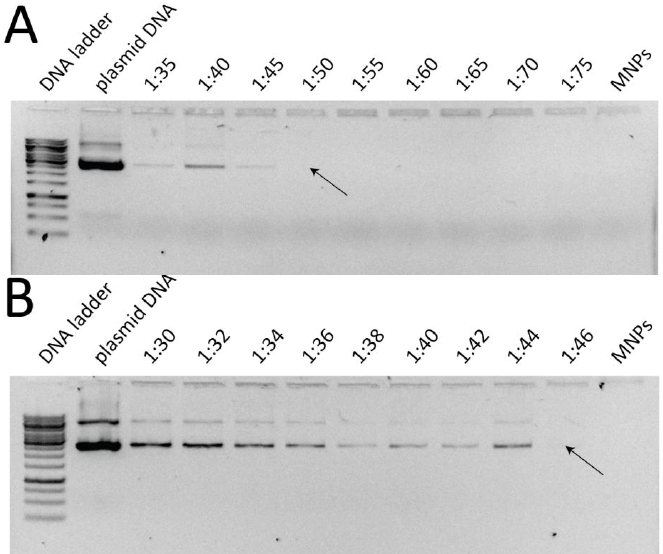
Figure 3. Assessment of DNA binding capacity of nanoparticles in gel-retardation assays. The assays were used to determine the pDNA/MBP ratio at which all pDNAs was bound to chi-MNPs ( A ) and lip-MNPs ( B ). Arrows indicate the ratio at where gel-bands representing pDNA were no longer visible indicative of a complete association between pDNA and the